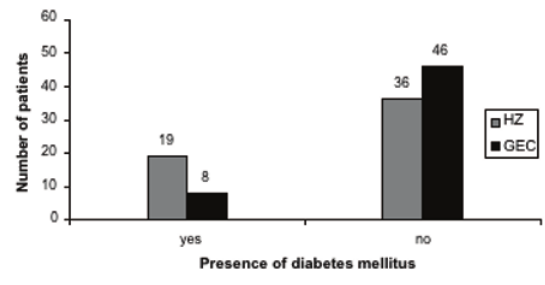
Figure 3. The prevalence of diabetes mellitus in the herpes zoster and control group, the Clinic for Infectious Diseases UCH Mostar in the period from January, 1 st 2005 to December, 31 st 2010. (HZ–Herpes zoster, GEC–gastroenterocolitis).